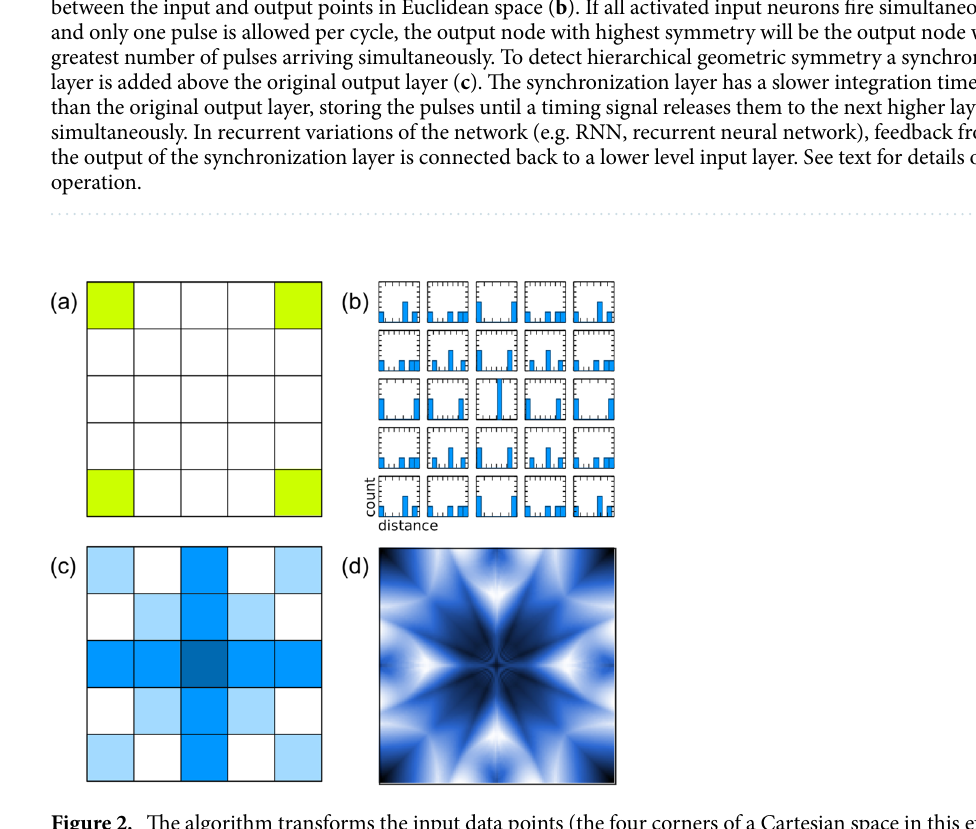
Figure 2. The algorithm transforms the input data points (the four corners of a Cartesian space in this example) ( a ) into an array of histograms of distances ( b ) where each bin counts the distance from the point in space to each data point. The peaks of the set of histograms are used to create a density of symmetry ( c ) overlaying the original space. Applying the algorithm repeatedly with feedback in a high-resolution space produces a fractal- like pattern ( d ) of hierarchical